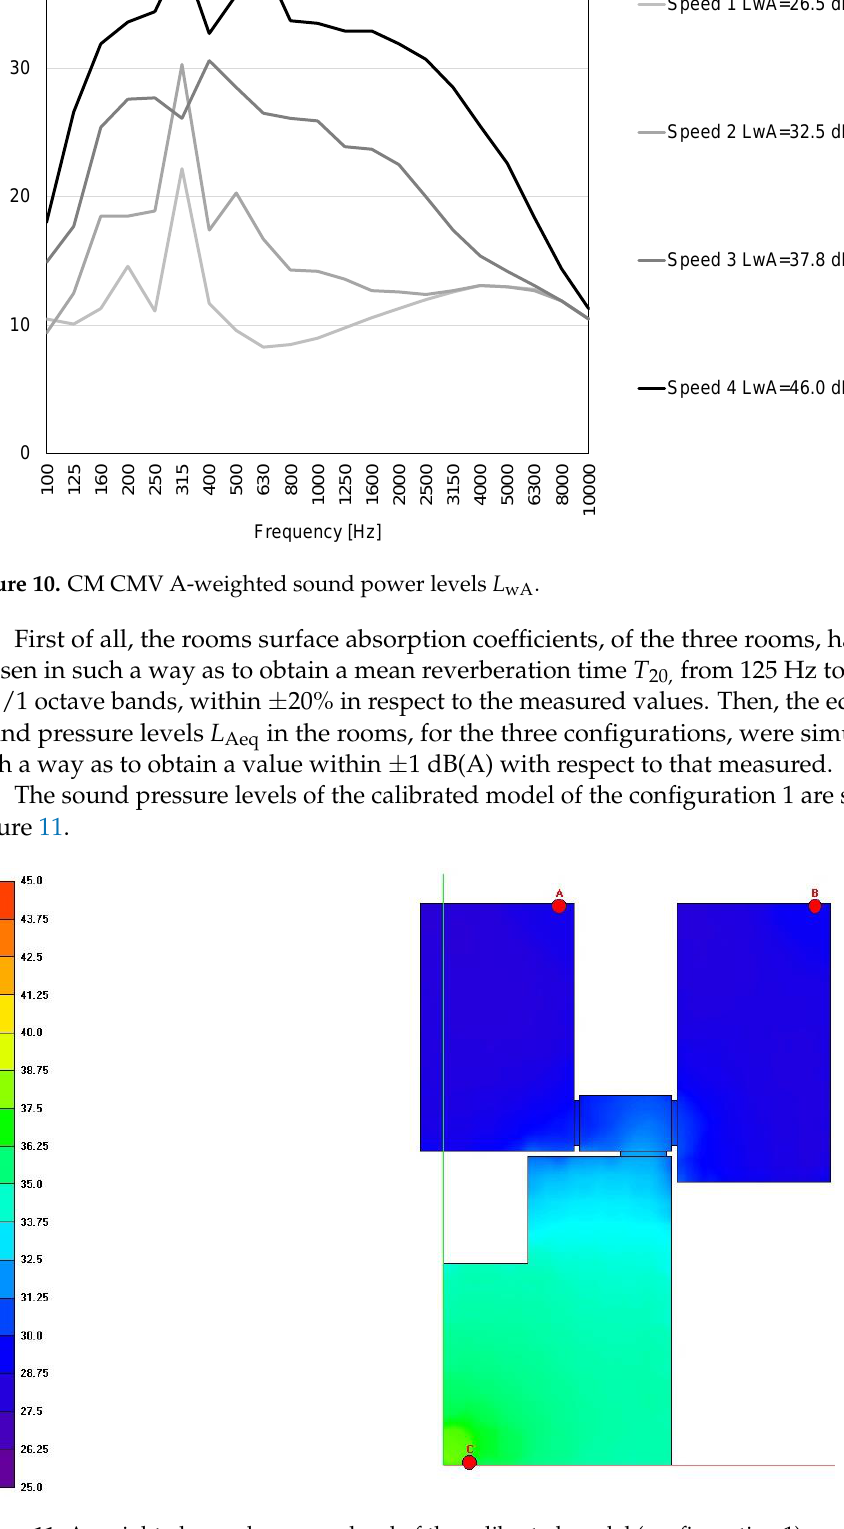
Figure 11. A-weighted sound pressure level of the calibrated model (configuration 1). The calibration of the model was fundamental in order to correctly set the calculation parameters of the software. The number of rays was considerably increased, in compari- son to the default software set up, in order to verify an adequate passage of pyramid rays through the open doors. For example, for single residential room analysis, it is sufficient to use a number of 2048 rays, while with coupled rooms connected by small openings (doors), 32,768 rays was necessary.